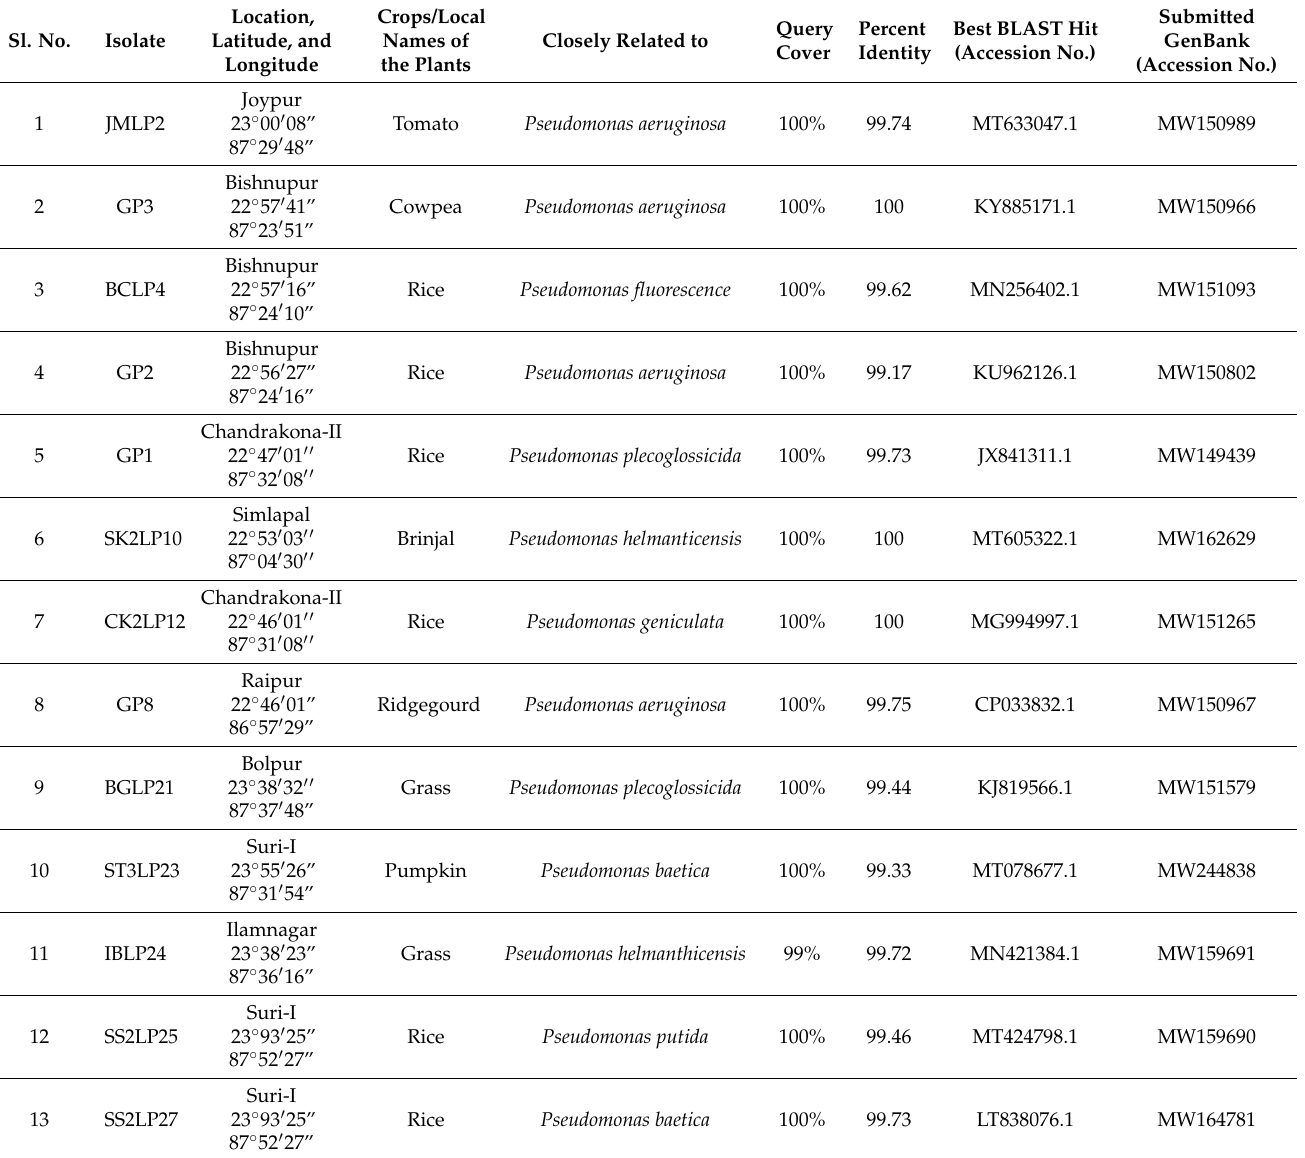
Table 8. Identification of different Pseudomonads isolates from red and lateritic areas of West Bengal through the BLAST search of the 16S rDNA